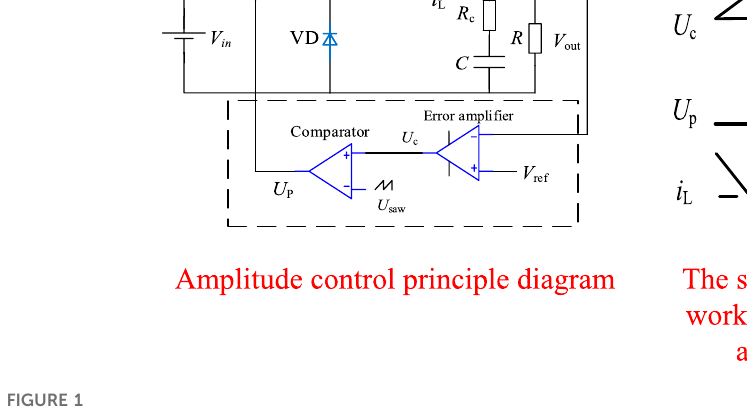
Buck converter variable amplitude